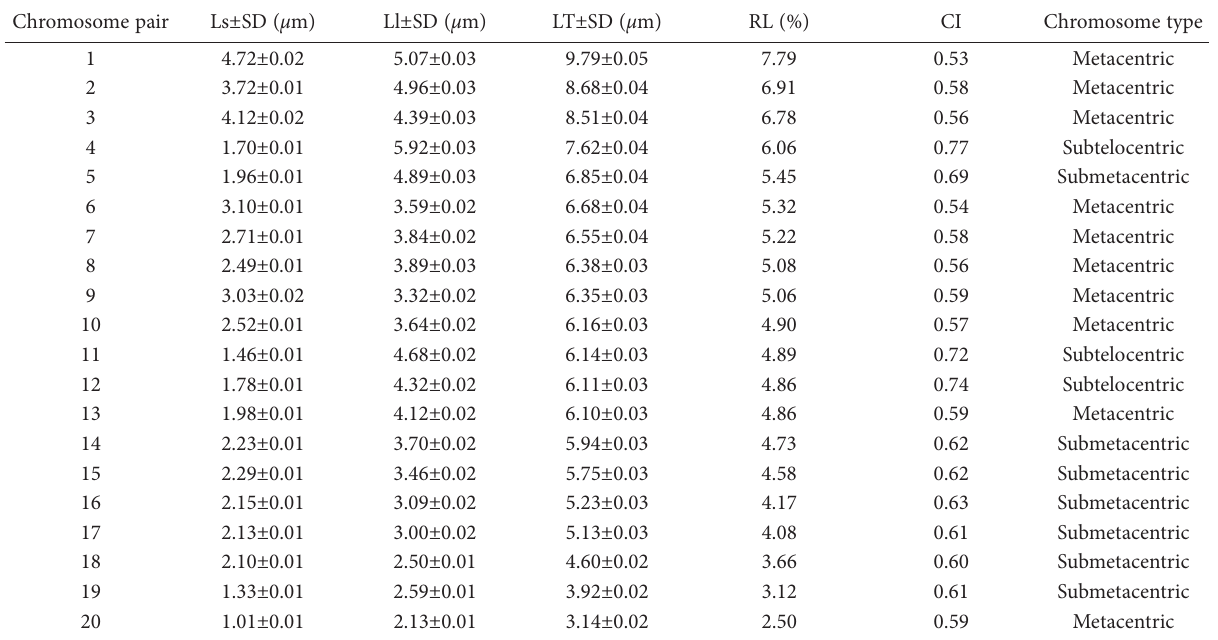
Table 2. Mean length of short arm chromosome (Ls), long arm chromosome (Ll), total arm chromosome (LT), relative length (RL), centro- meric index (CI) and standard deviation (SD) of RL, CI from 20 metaphases of Ag. modestum (2 n =40). Chromosome pair